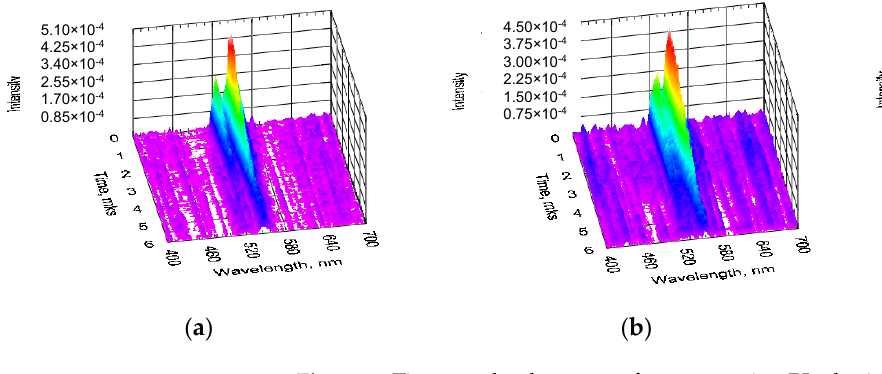
Figure 3. Time-resolved spectra of upconversion PL obtained from BaTiO 3 :Er (sample B) ( a , b ) and BaTiO 3 :(Er,Yb) (sample D) ( c ) xerogel layers deposited on a silicon wafer using a porous SrTiO 3 xerogel sublayer. The spectra were measured under pulsed excitation with the wavelengths of λ ex = 980 nm ( a , c ) and λ ex = 1540 nm ( b ). The intensity of the upconversion PL signal is plotted as a function of the wavelength and the time delay after the laser pulse.